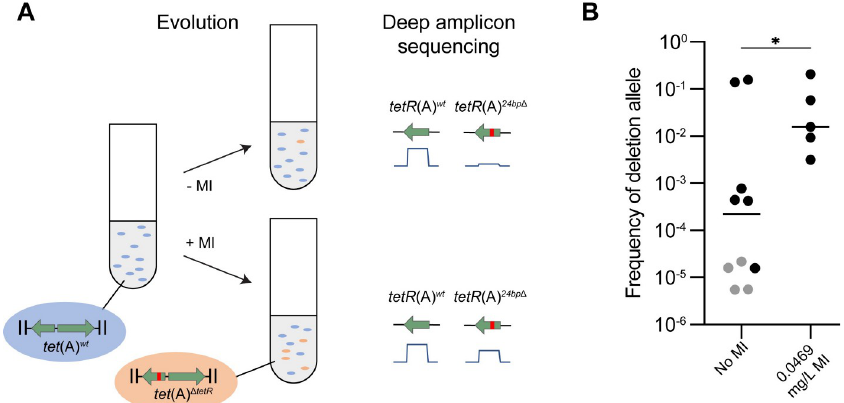
Fig 6. Evolution of tet (A) during prolonged growth. ( A ) Principle of evolution experiment. A strain carrying a wild- type tet (A) with a wild-type tetR (A) gene was grown with (+MI) or without ( − MI) minocycline. The frequency of bacteria with spontaneous 24-bp deletion in tetR (A) ( tet (A) Δ tetR allele) at the end of the evolution experiment was determined using deep amplicon sequencing and the sequencing coverage for each tetR (A) allele. ( B ) Frequency of bacteria with tetR (A) Δ 24bp mutations at the end of the evolution experiment (see S9 Table). Results are after 196 generations without antibiotics ( n = 10) or 0.0469 ( n = 5) mg/L MI. In grey are maximum frequencies due to absence of detected tetR (A) Δ 24bp mutations in at least 1 of the amplicon sequencing technical repeats. Median is shown. � : p < 0.5 (Wilcoxon rank sum test). MI, minocycline.